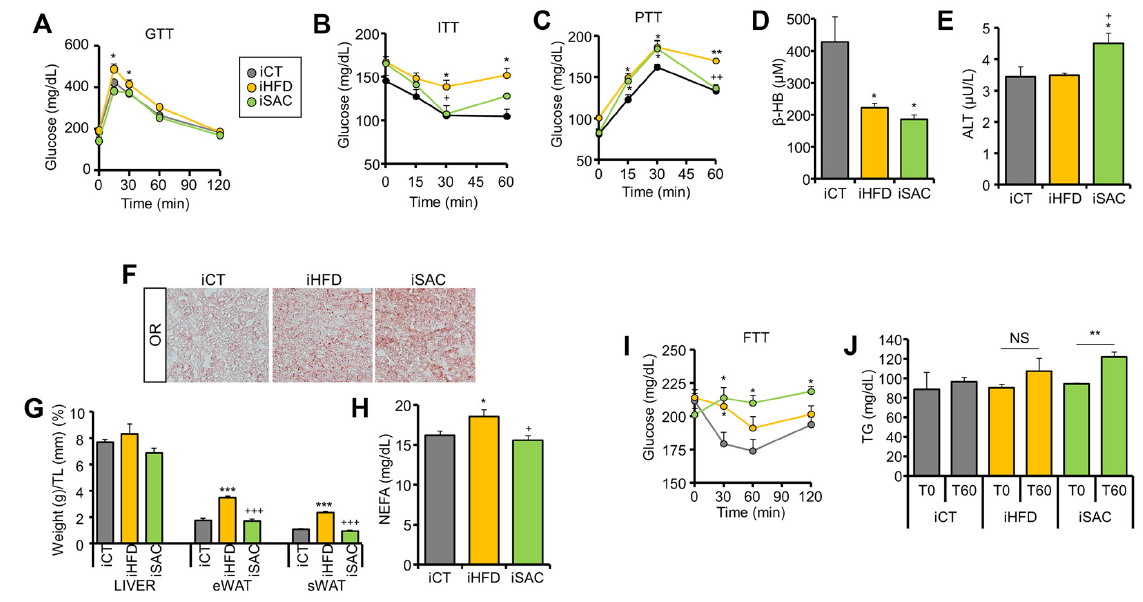
Figure 5. Injection of HFD and SAC plasma exosomes reproduce the metabolic phenotype observed in donor mice. ( A , B ): iHFD but not iSAC show glucose intolerance ( A ) and insulin resistance ( B ). ( C , D ): Both experimental groups show increase glucose output during a PTT ( C ), and lower circulating β -HB levels ( D ). ( E ) Only iSAC mice have increased alanine transaminase (ALT) activity. ( F ) Both experimental groups display hepatic steatosis. ( G , H ): Only iHFD mice show significant enlargement of adipose depots ( G ) and elevated circulating NEFA levels ( H ). ( I , J ): Oral administration of fructose increased glycemia ( I ) and circulating TG ( J ) only in iSAC mice. n = 4/group ( A – J ). * p < 0.05, ** p < 0.01, and *** p < 0.005 with respect to the iCT group. + p < 0.05, ++ p < 0.01, and +++ p < 0.005 with respect to the iHFD group. NS = not significant.